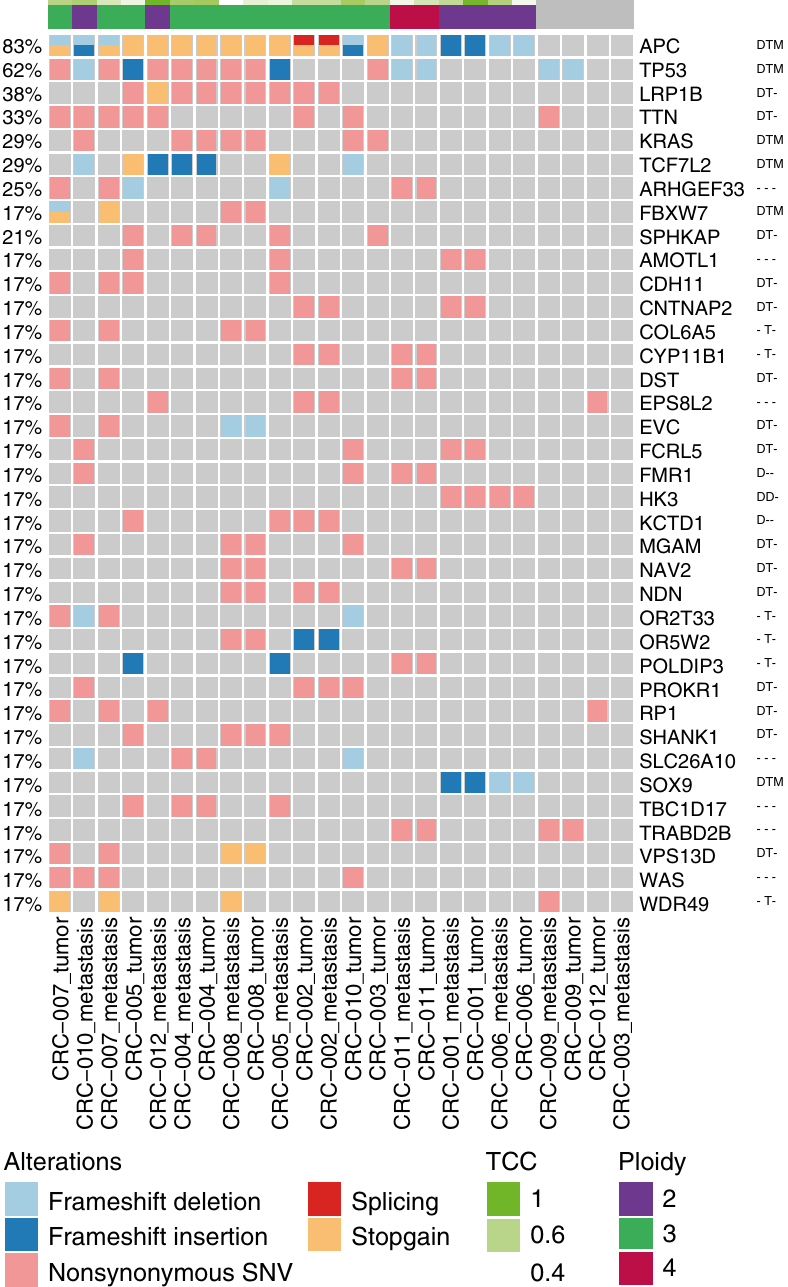
Fig. 1 Recurrent somatic small mutations on protein coding genes. Oncoprint representation of recurrently mutated genes with a cutoff of 4 samples (17%). The top annotation shows the tumor cell content (TCC) and estimated tumor ploidy. The color of the box indicates the type of mutation. Recurrently mutated genes are marked with D, T, M if they were also recurrently mutated (>2.5%) in the Giannakis et al./DFCI 2016 (D), TCGA provision (T) and Yaeger et al./MSK-CC 2018 cohorts (M) via cBioPortal NATURE COMMUNICATIONS| (2018) 9:4782 |DOI: 10.1038/s41467-018-07041-z|www.nature.com/naturecommunications